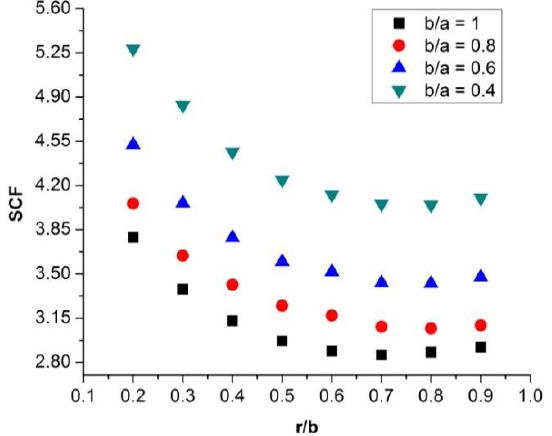
Figure 5. Relative variation of predicted values of SCF using FEM